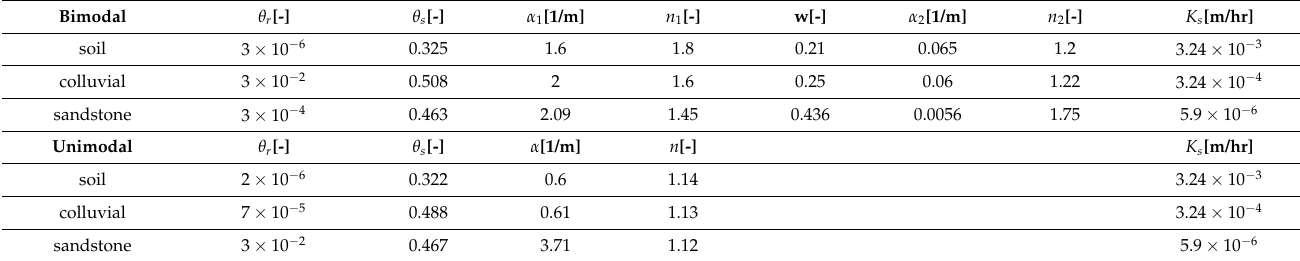
Table 2. Unimodal and bimodal soil water retention curve